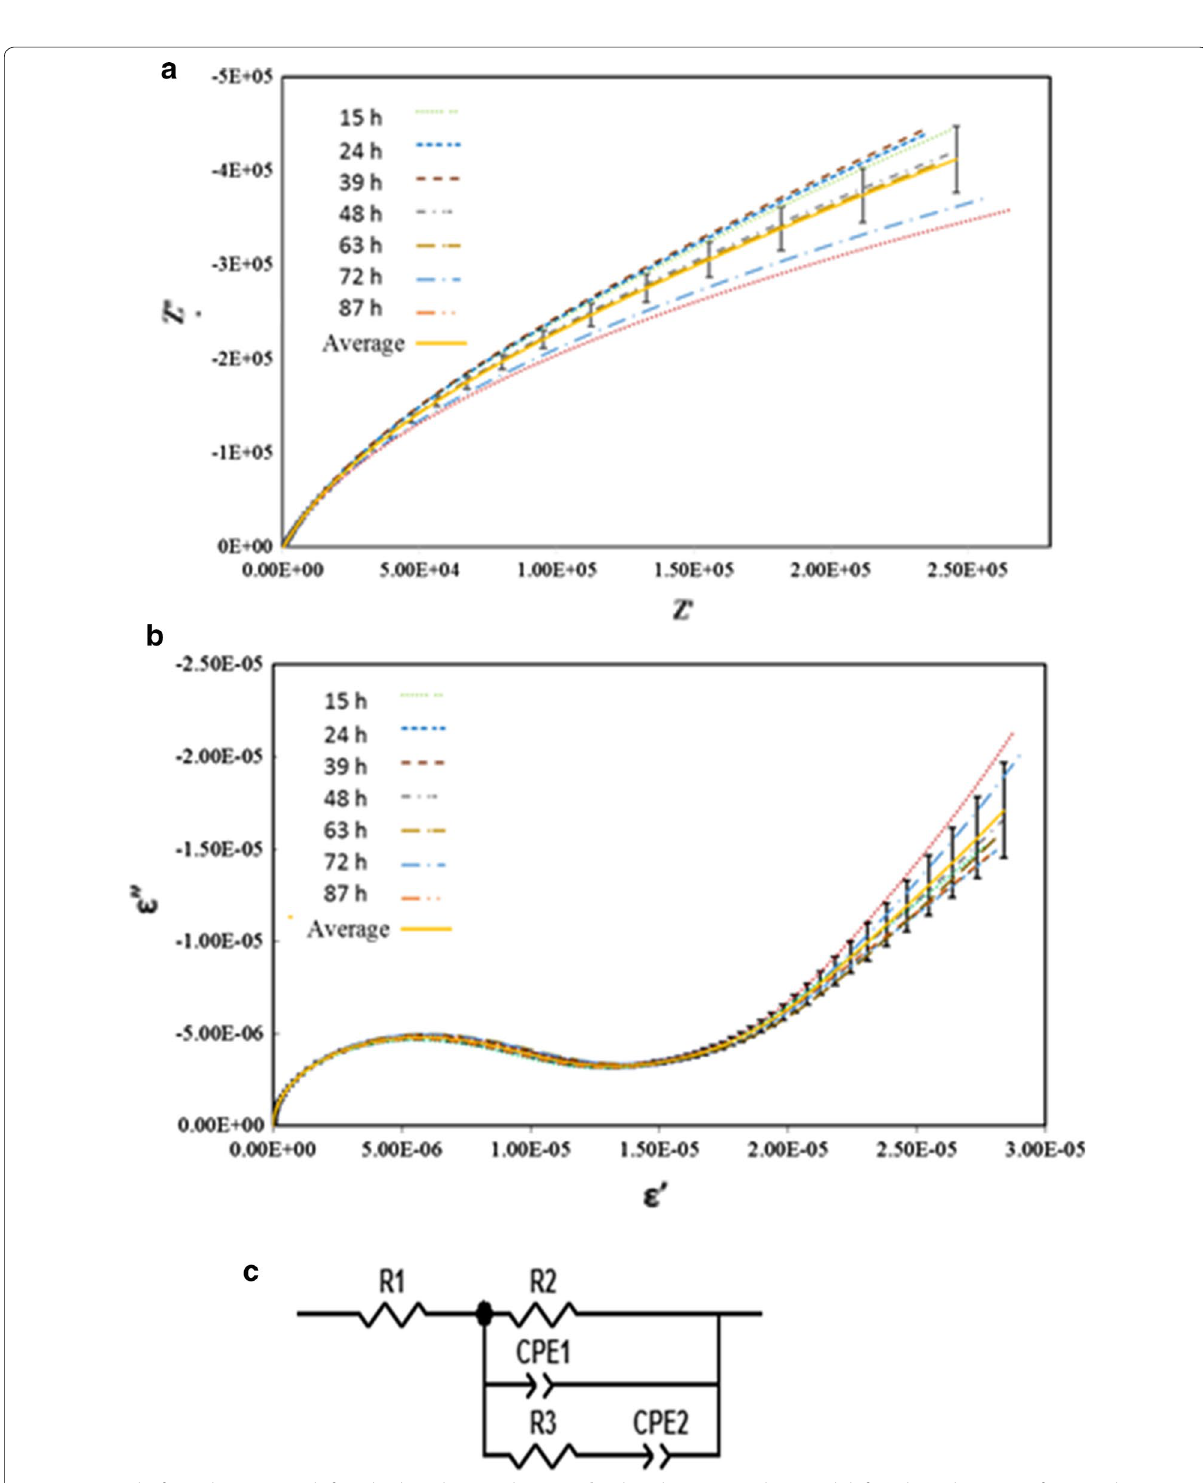
Fig. 4 EIS results from abiotic controls from both Bode ( a ) and Nyqyist ( b ) plots demonstrated minimal drift and good precision from 100 kHz to 0.01 Hz. throughout the course of the study. The equivalent circuit ( c ) used to fit the data where R1 represents electrolyte resistance at high frequency, CPE1 and R2 represent a constant phase element and charge transfer resistance, respectively at lower to medium frequencies, with CPE2 and R3 representing a constant phase element and a modification of the charge transfer resistance respectively at low to high